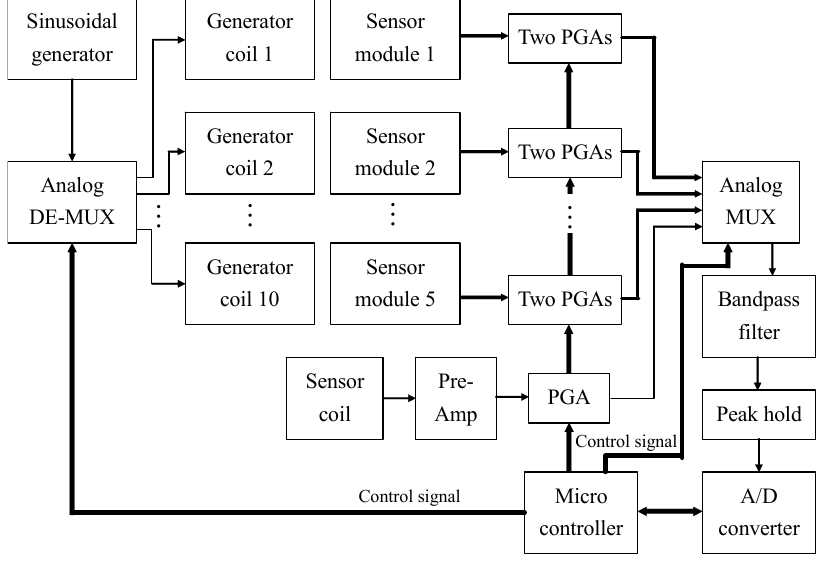
Figure 11. The block diagram of the data glove control